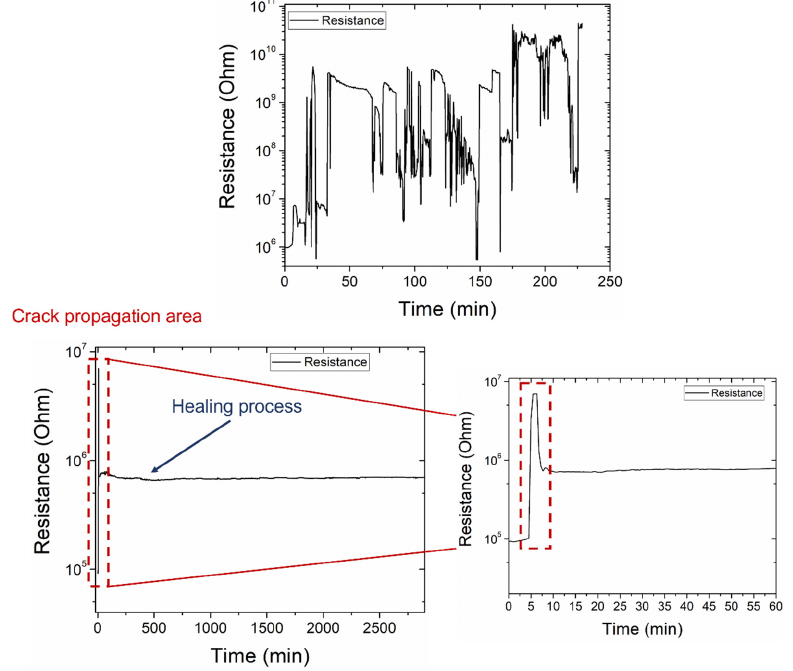
Figure 14. Online monitoring of resistance during the experimental procedure (damage and self- healing) of lap strap specimens containing neat ( up ) and capsules with nanomodified healing agent ( down ).